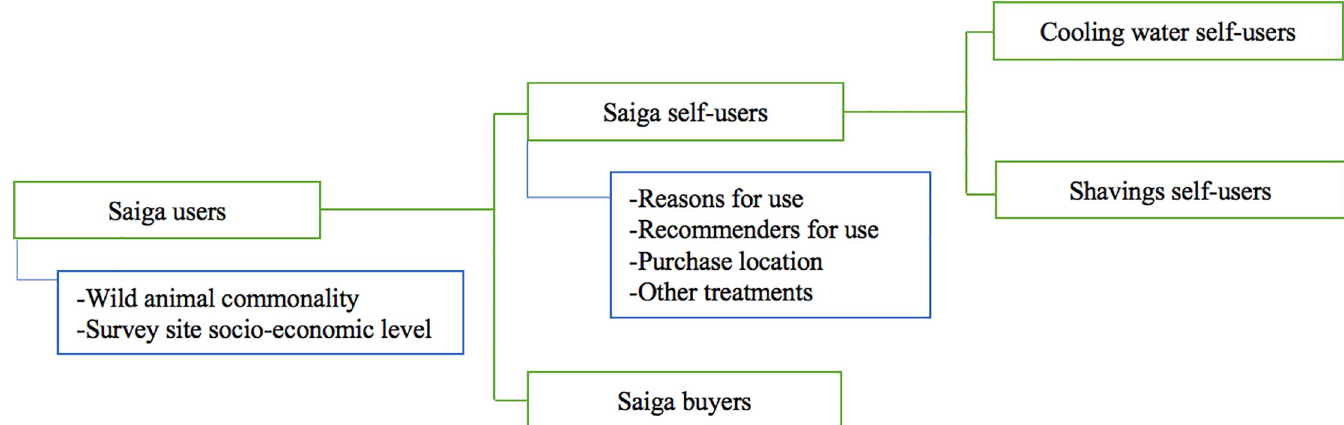
Fig 1. Data analysis breakdown. Data analysis breakdown showing saiga horn sub-user groups, assessed using averaged GLMs with contrasts, along with the additional questions that are asked of two groups of particular interest. All respondents who use and/or buy saiga horn for themselves and/or others are considered "saiga users". Respondents who use it themselves are considered "saiga self-users", and those who buy for others are "saiga buyers" (self-users and buyers are not mutually exclusive, and both are subsets of users). Within saiga self-users, we also characterised respondents who stated that the saiga products they purchase most often are cooling water or shavings.